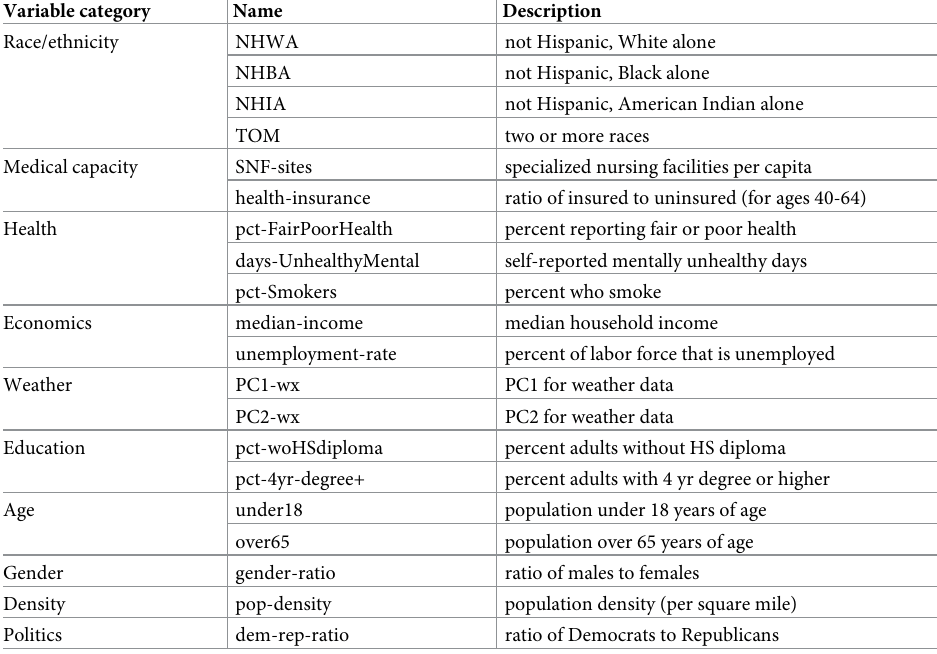
Table 3. Important variables for county-level COVID-19